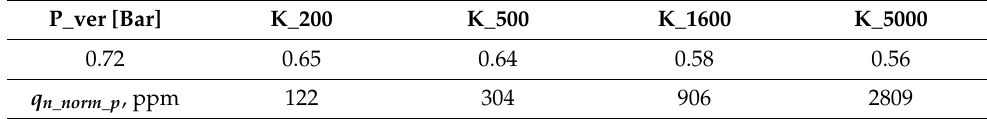
Table 4. Compensated factors for P_ver on all calibration